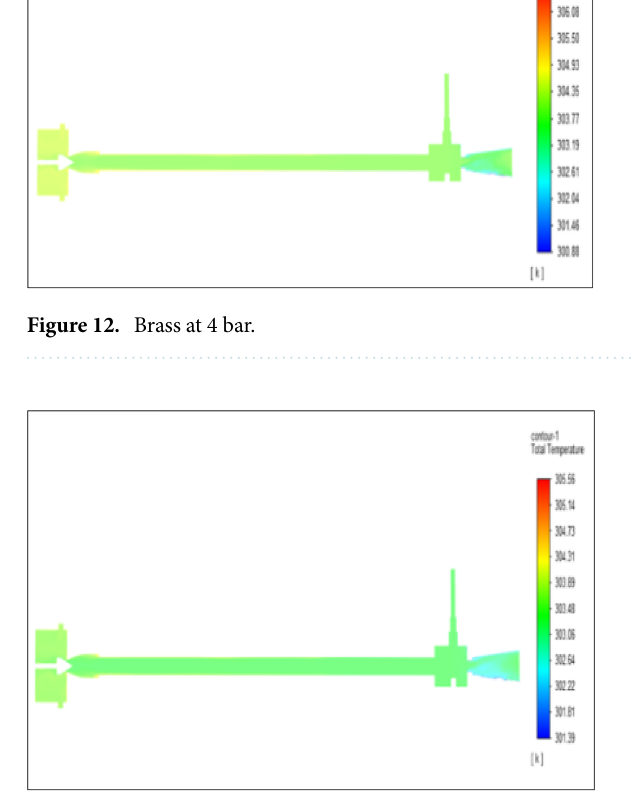
Figure 13. PVC at 4 bar.